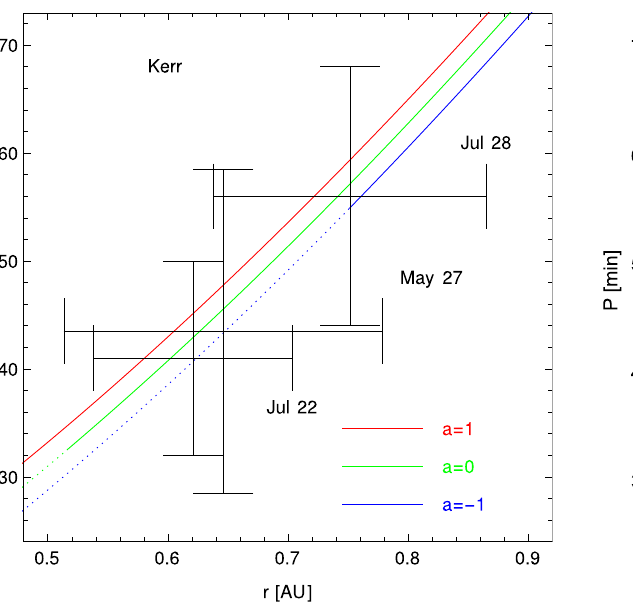
the observed positions and periods of the flares. The starting points of the solid curves represent the ISCO positions, while dotted, and solid parts of the curves are plotted for below and above the ISCO positions, respectively. Right: Orbits of neutral hot-spot moving around Kerr BH with three different BH masses M = { 3 , 4 . 3 , 7 } × 10 6 M (cid:3) , but having the same spin a = 0 . 4, fitting